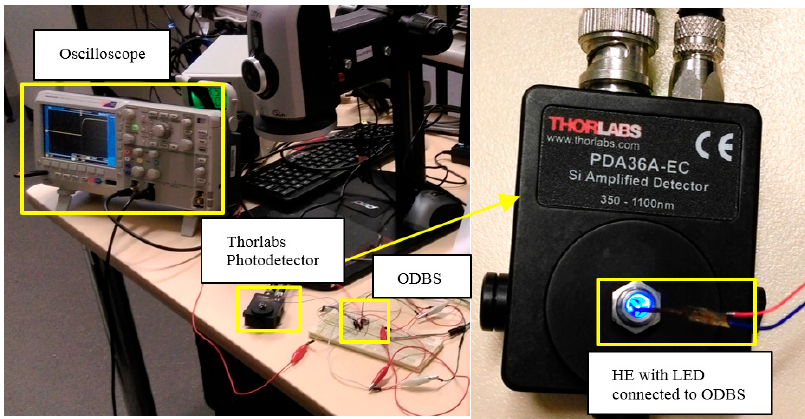
Figure 9. Setup for the electrode analysis.